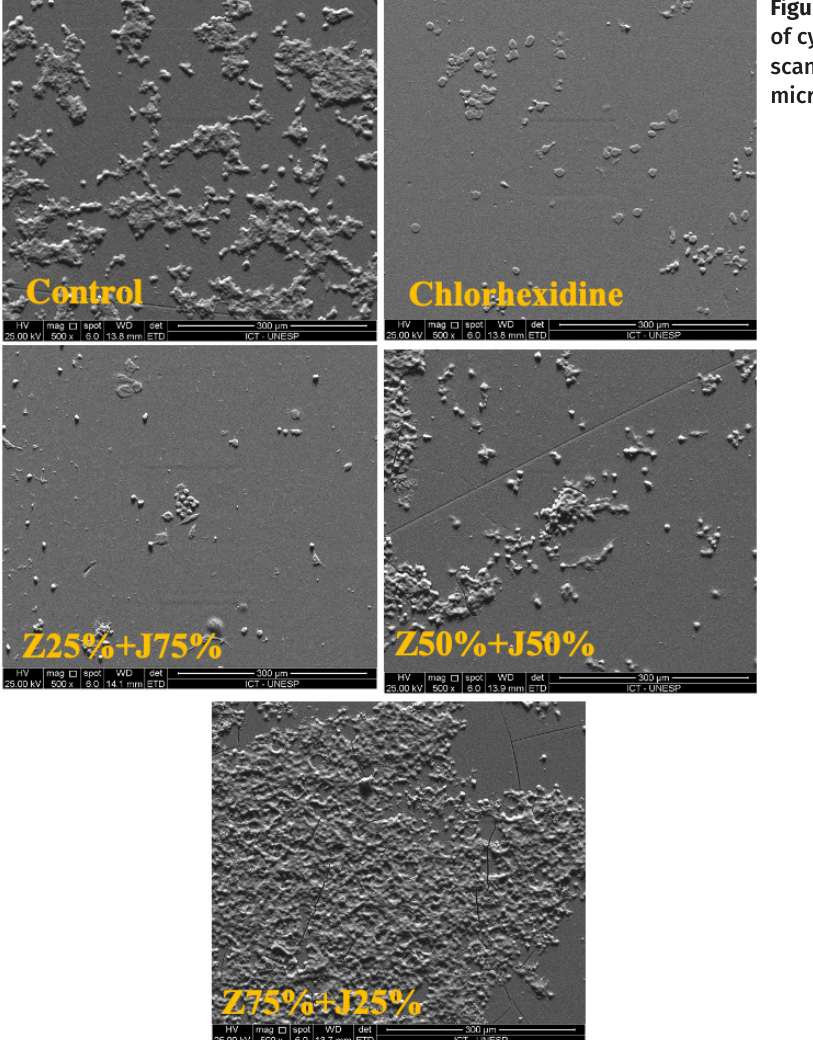
Figure 5. Analysis of cytotoxicity by scanning electron